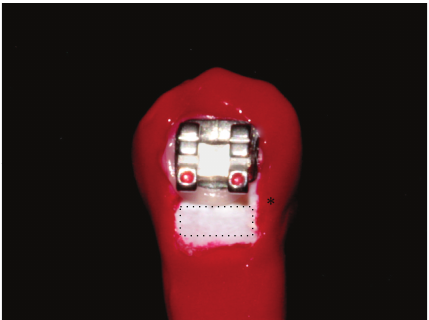
Figure 1: Photo showing a tooth with an orthodontic bracket and the enamel area that was exposed to the artificial demineralization (dotted rectangle). The asterisk ( ∗ ) indicate the control area for QLF measurements, covered with nail